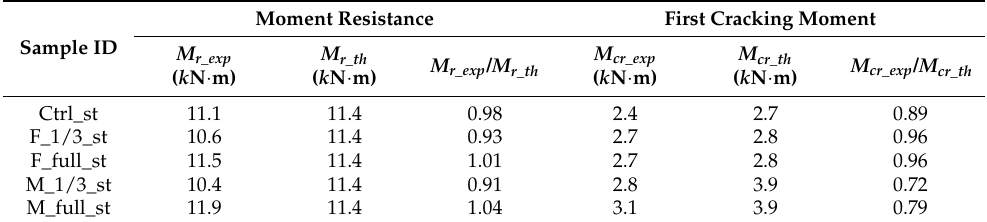
Table 8. Experimental and theoretical moment resistance and first cracking